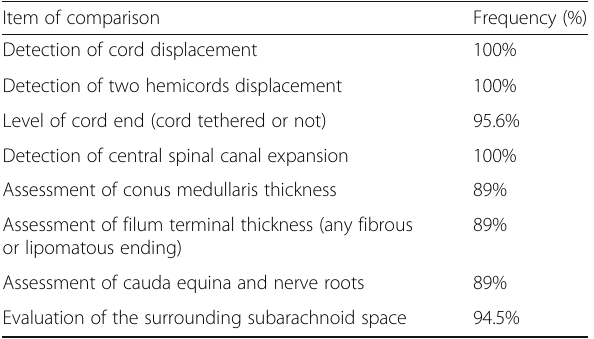
Table 5 Agreement between USG and MRI findings in terms of spinal cord morphology in patients aged ≤ 2 years old